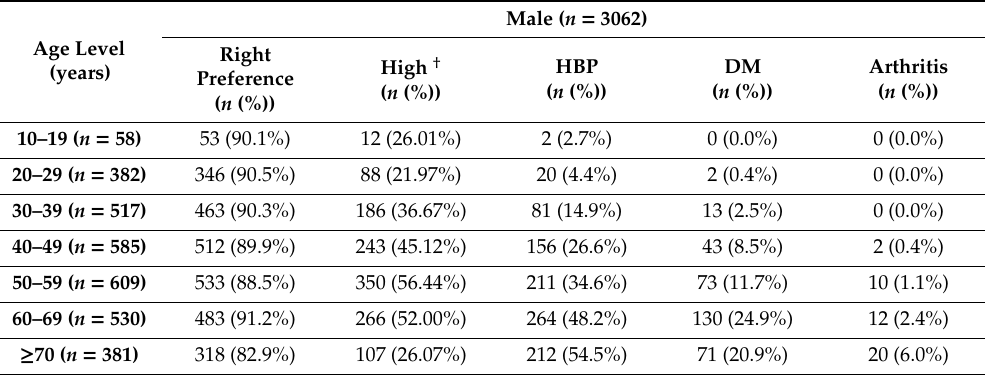
Table 1. The General Characteristics of Participants ( n =